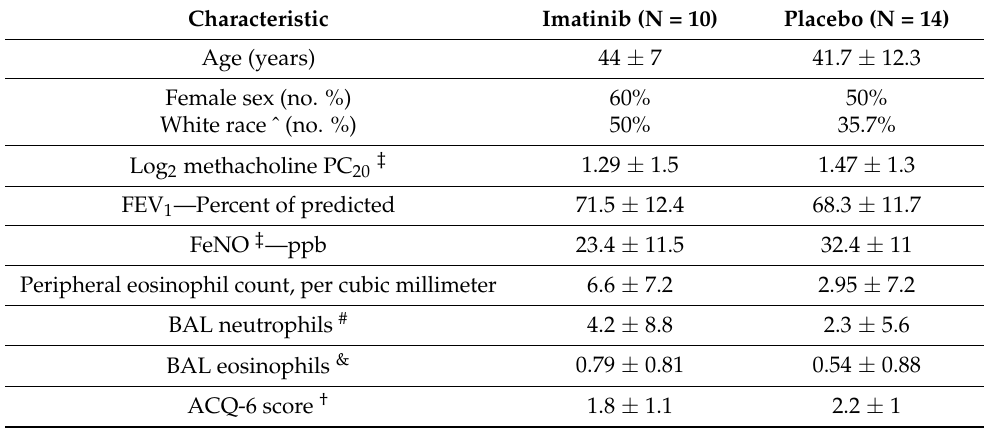
Table 1. Baseline demographic characteristics * of patients included in bronchial brushing